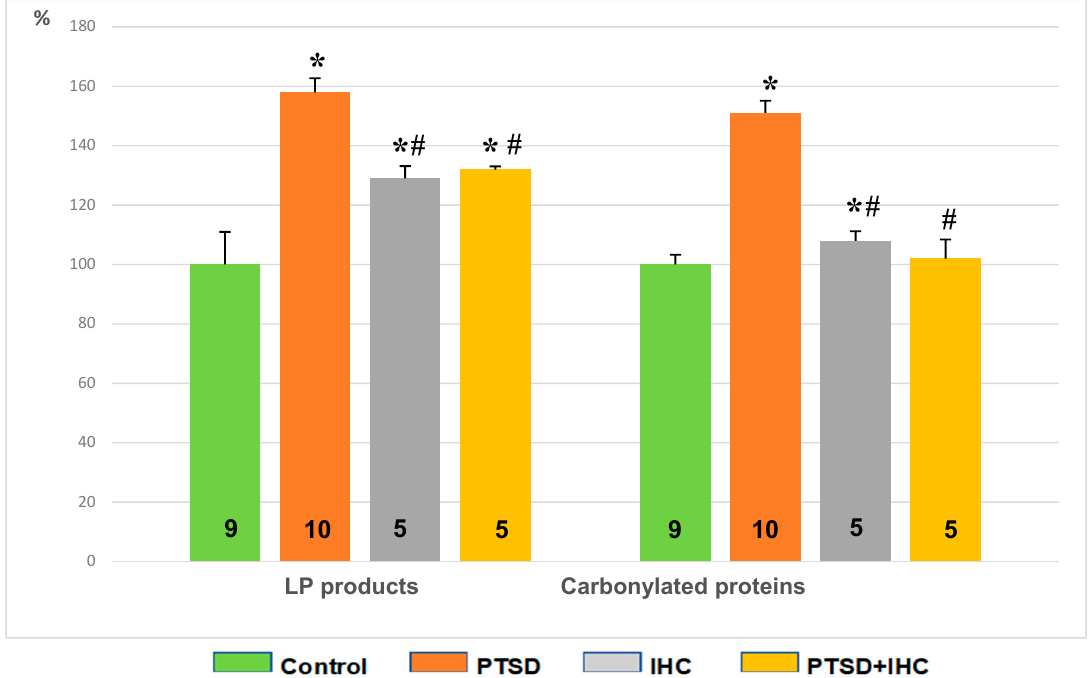
Figure 8. E ff ects of PTSD, IHC, and PTSD + IHC on concentrations of oxidative stress markers in the rat liver. PTSD = posttraumatic stress disorder; IHC = intermittent hypoxic conditioning; LP = lipid peroxidation; data are presented as means ± SEM in per cent of control values (for control, LP products = 0.213 ± 0.07 oxidation conventional units; carbonylated proteins = 273 ± 27 oxidation conventional units). Numbers of rats in the groups are shown on the bars. * Significantly di ff erent from control; # significantly di ff erent from PTSD. Specific p values are stated in the text.